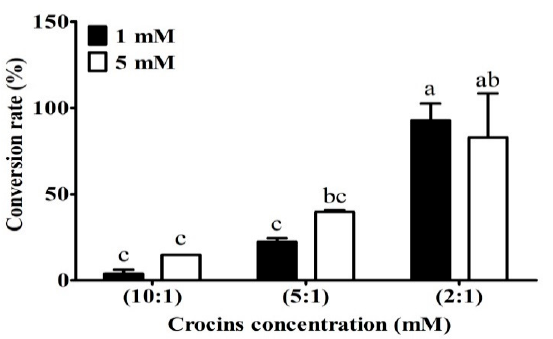
Figure 3. Conversion rate of different concentrations of crocins in enzymes. Crocins (at 1 mM and 5 mM, dissolved in 100 mM of citrate buffer, pH 5.0) and Celluclast ® 1.5 L at ratios 10:1, 5:1; and 2:1 ( v / v ) were incubated at 50 ◦ C. for 16 h. Different letters in the group indicate significant differences according to the Tukey’s multiple comparison test ( p ≤